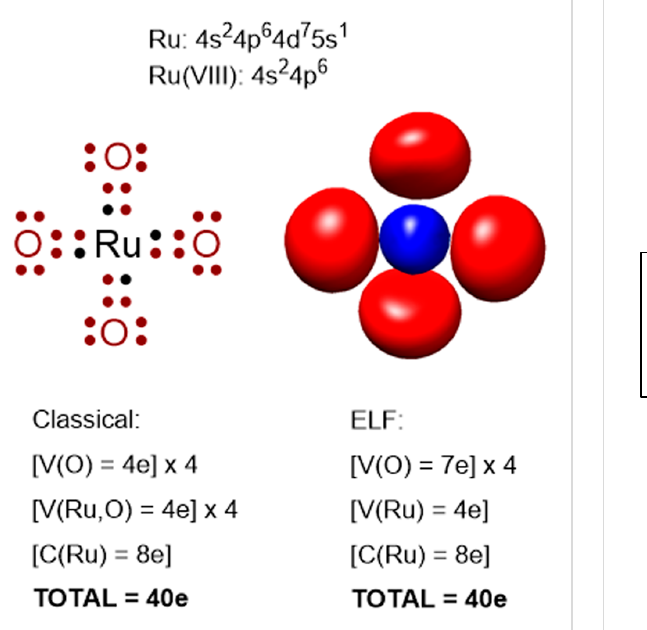
Figure 4: ELF assignment of electrons to the Ru environment. C(Ru) corresponds to a monosynaptic core basin assigned to ruthenium. V(Ru) and V(O) correspond to monosynaptic valence basins assigned to ruthenium and oxygen atoms, respectively. V(Ru,O) corresponds to a disynaptic valence basin assigned to a Ru–O bond (not present in ELF